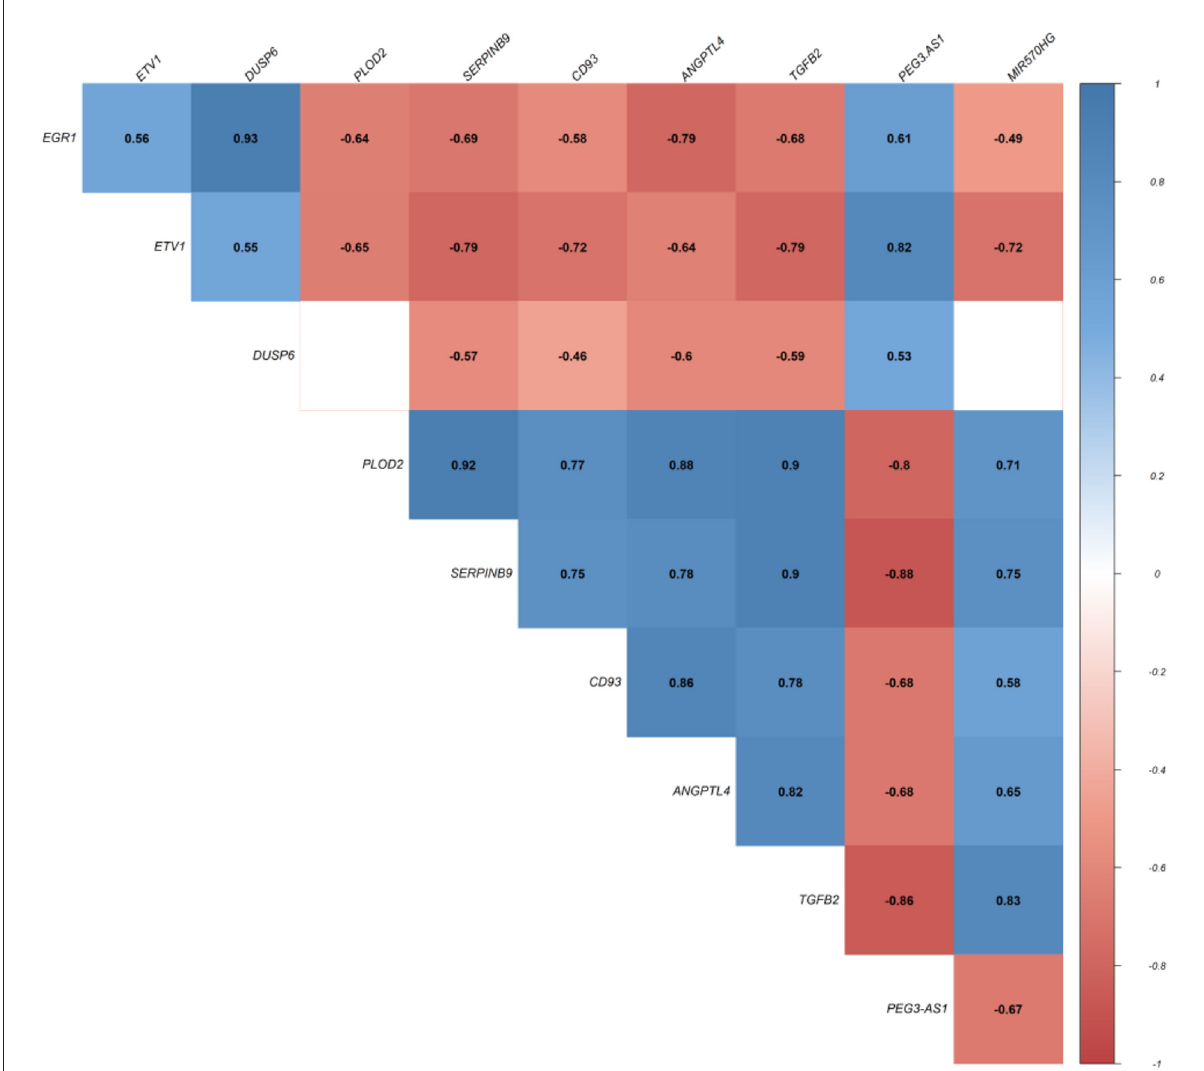
FIGURE3 Pearson correlation analysis. Values represent Pearson’s correlation coefficient ( r ). Positive correlations are shown in blue, while negative correlations are represented in red. False discovery rate (FDR) values greater than 0.001 are deemed unimportant (blank), and the intensity is proportional to correlation